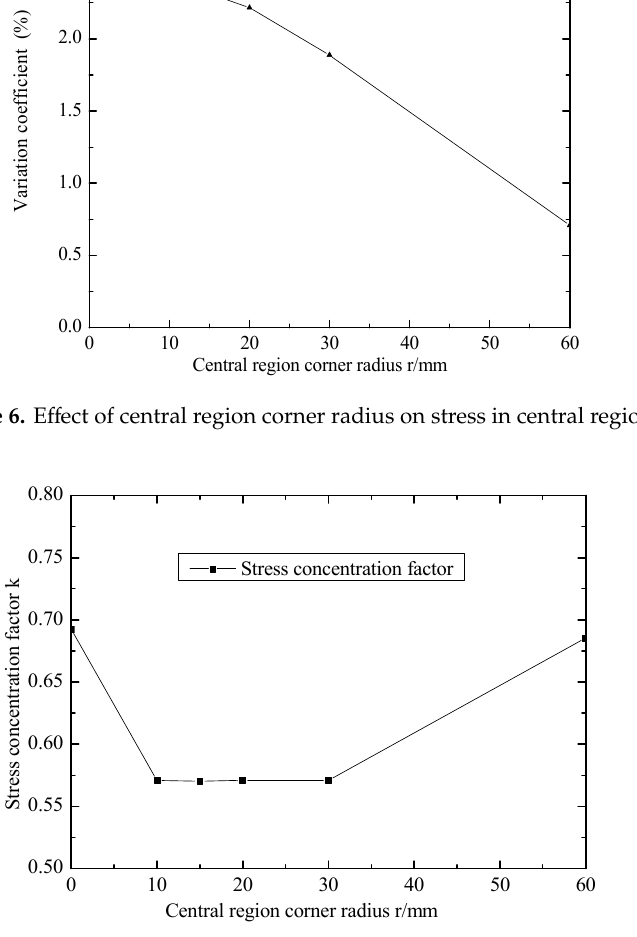
Figure 7. E ff ect of central region corner radius on stress concentration factor. Figure 7. Effect of central region corner radius on stress concentration factor.